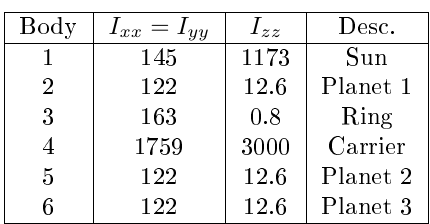
Table 2: More realistic mass/inertia matrix [kg · m 2 ].